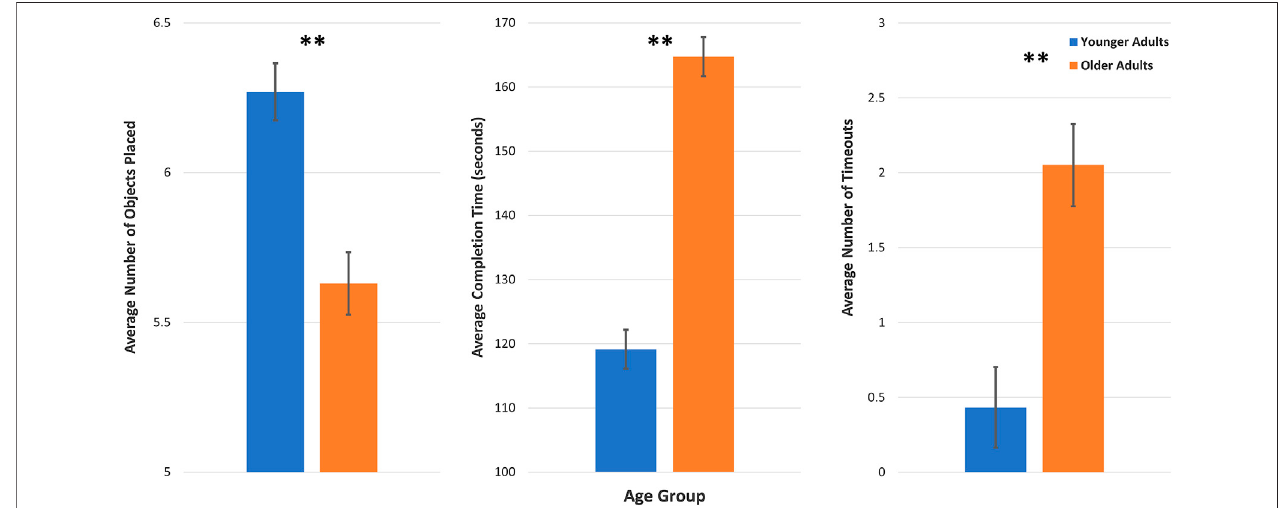
FIGURE 4 | Behavioral results in real-world task across younger and older adult